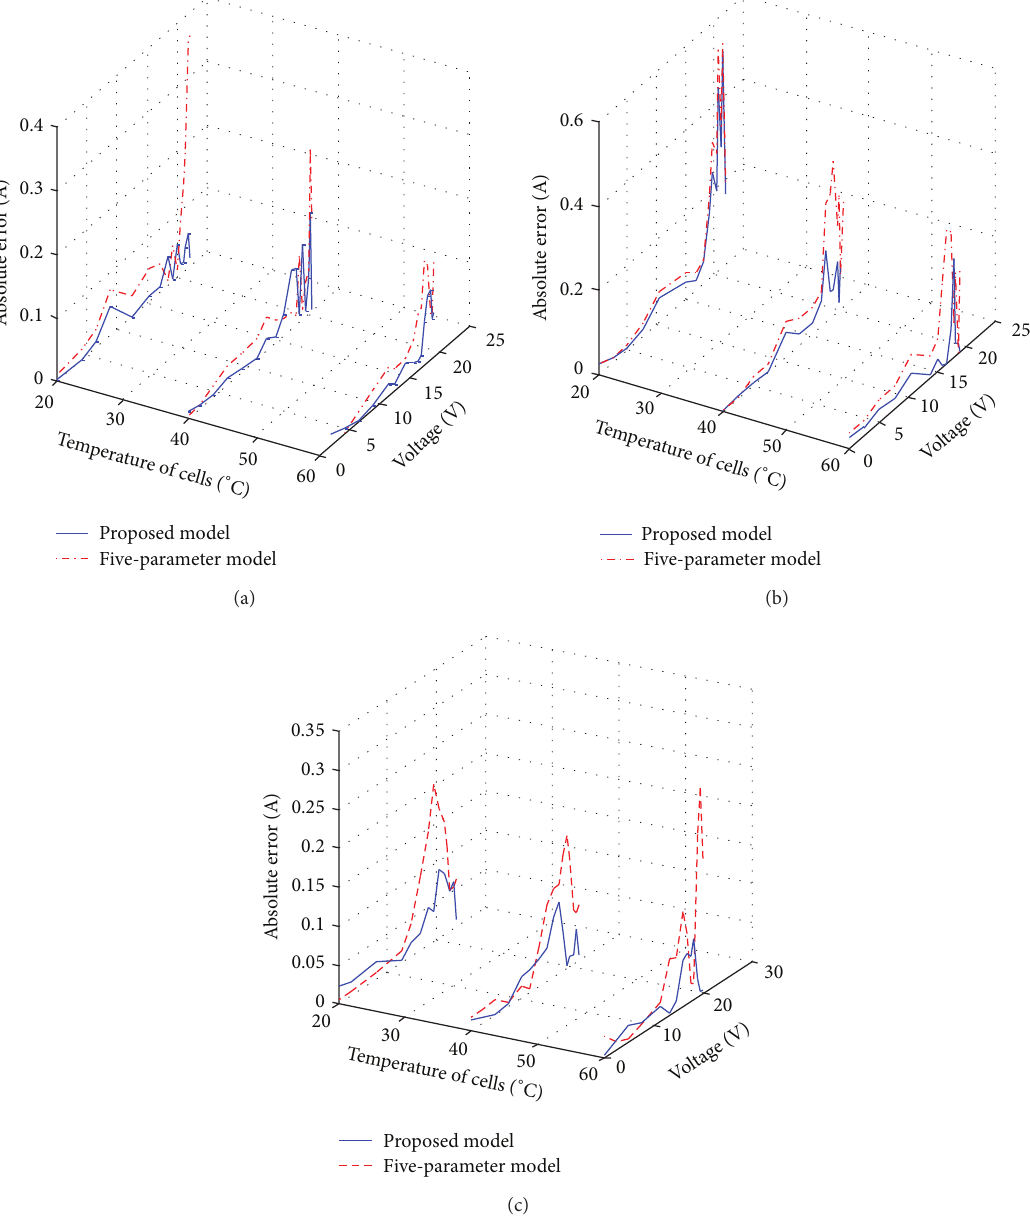
Figure 6: Absolute errors for different temperature levels of Shell SM55 (a), Shell S75 (b), and Shell ST40 (c).